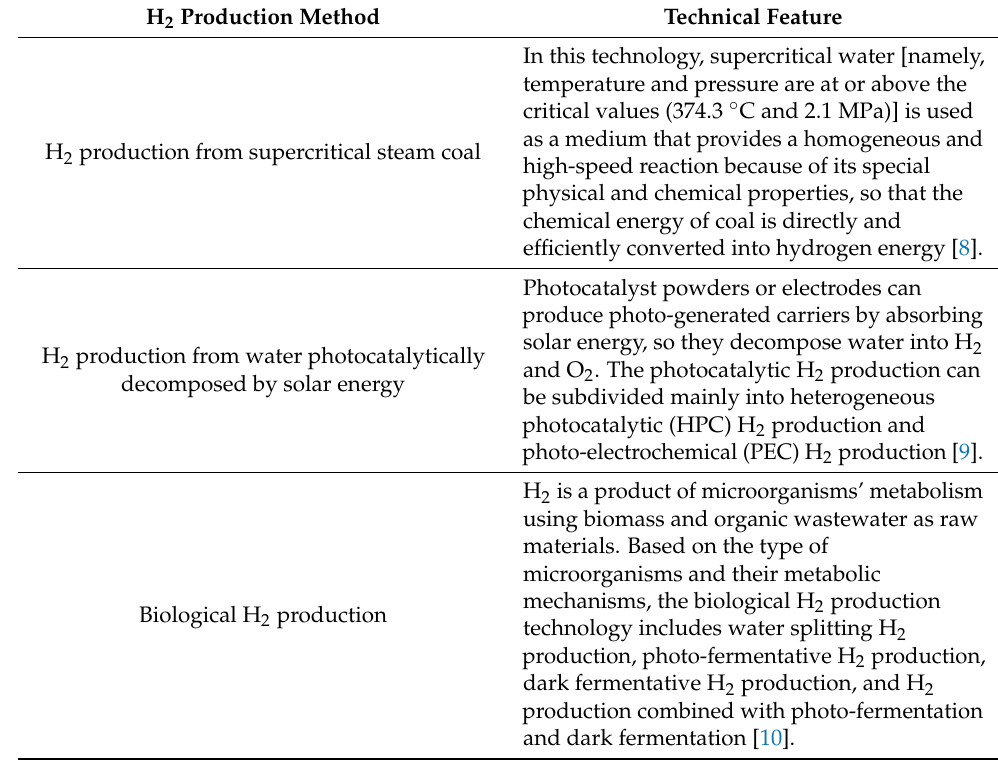
Table 1. Emerging H 2 production